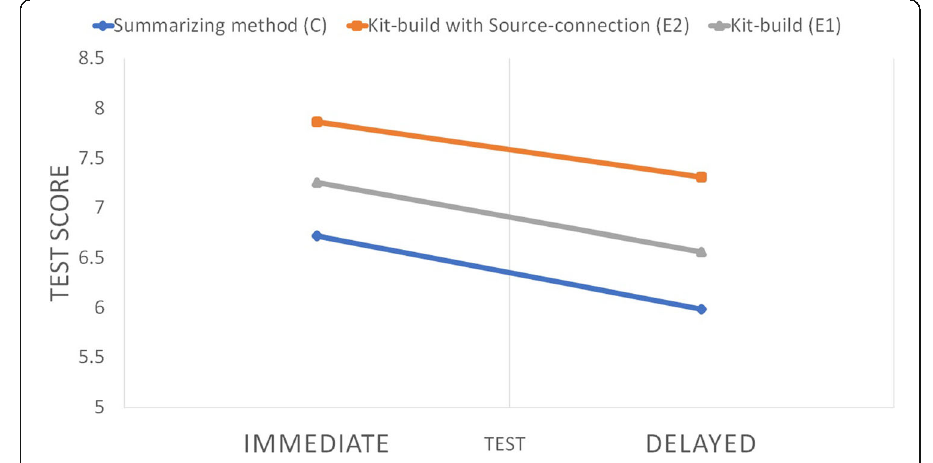
Fig. 5 Graphical test result comparison between groups for Material